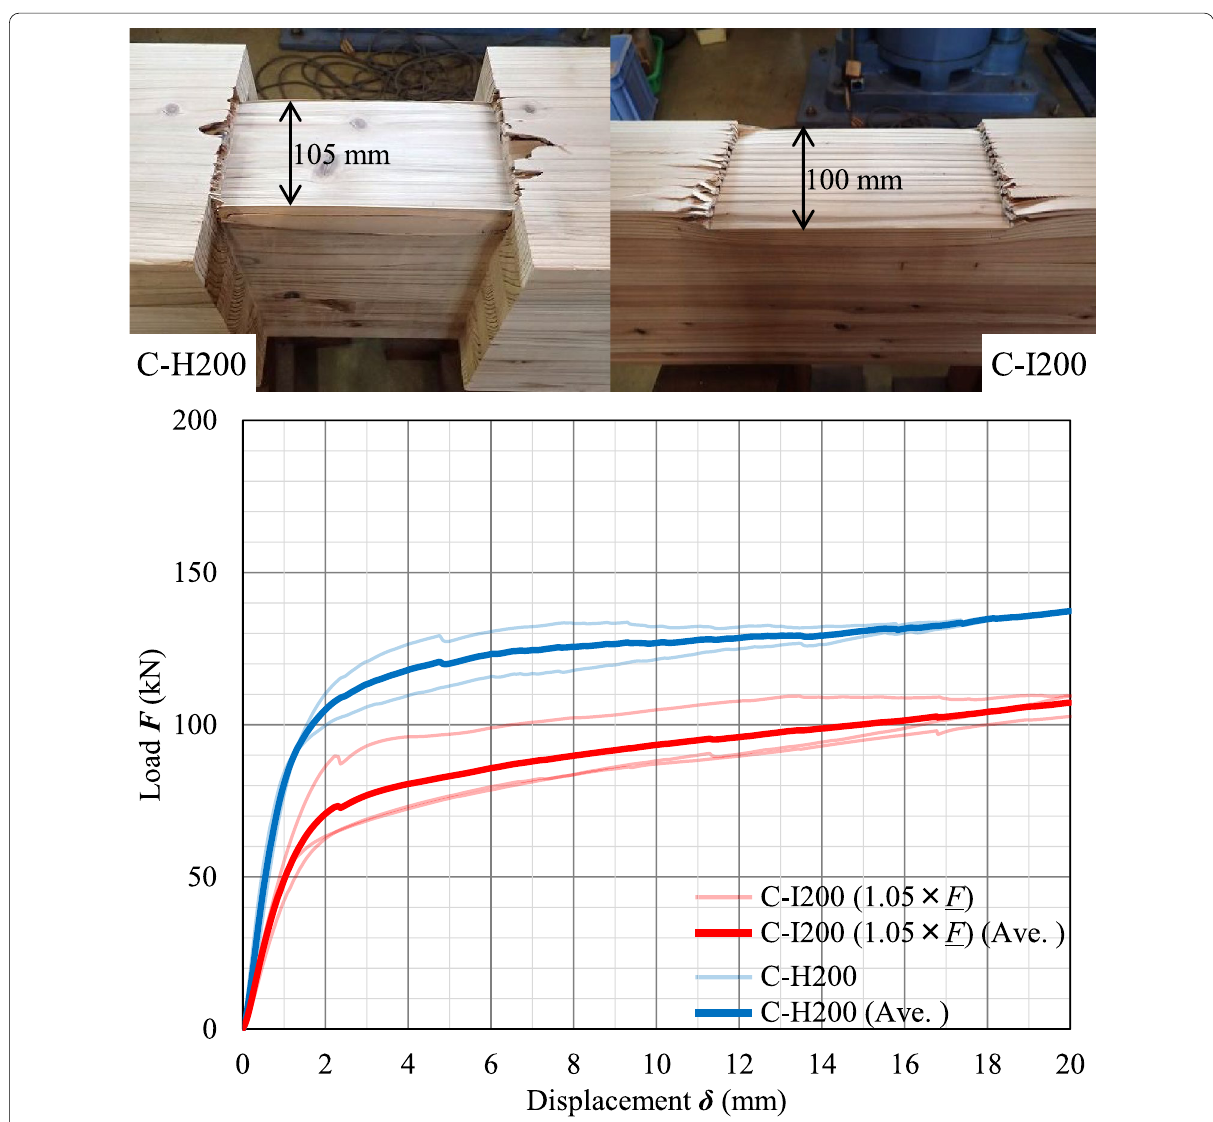
Fig. 20 Relationship between the force point load F and displacement δ of C-H200 and